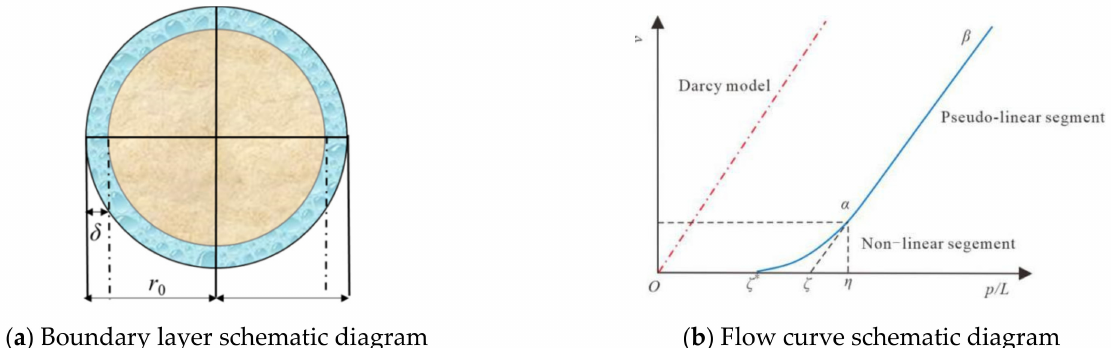
Figure 2. Non-linear flow model schematic